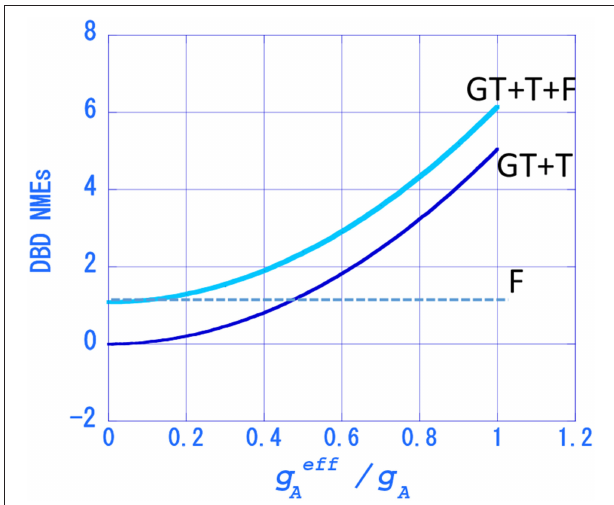
FIGURE 6 | Neutrinoless NME as a function of the renormalization (quenching) factor of g eff A / g A . Thick line: M 0 ν . Thin line: ( g eff A / g A ) 2 ( M 0 ν QR ( GT ) + M 0 ν QR ( T )). Dotted line: ( g V / g A ) 2 M 0 ν QR ( F ).